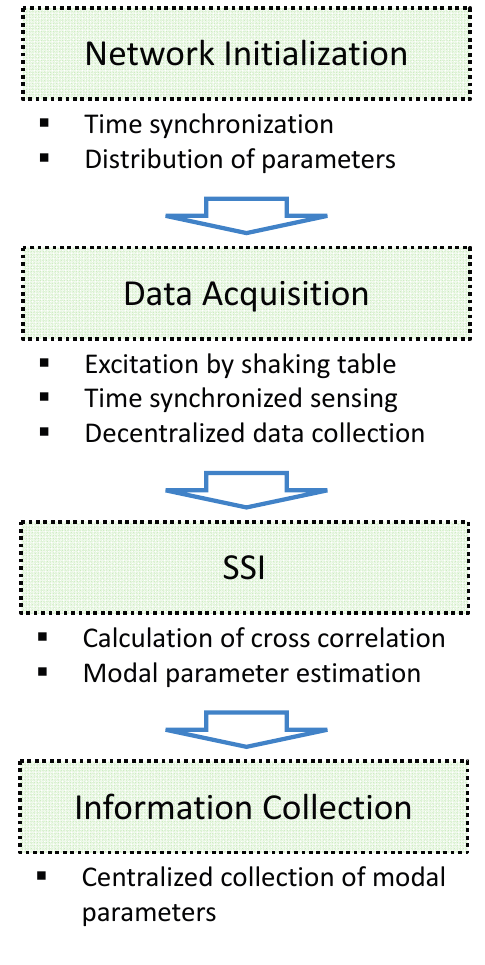
Figure 6. Flowchart of the